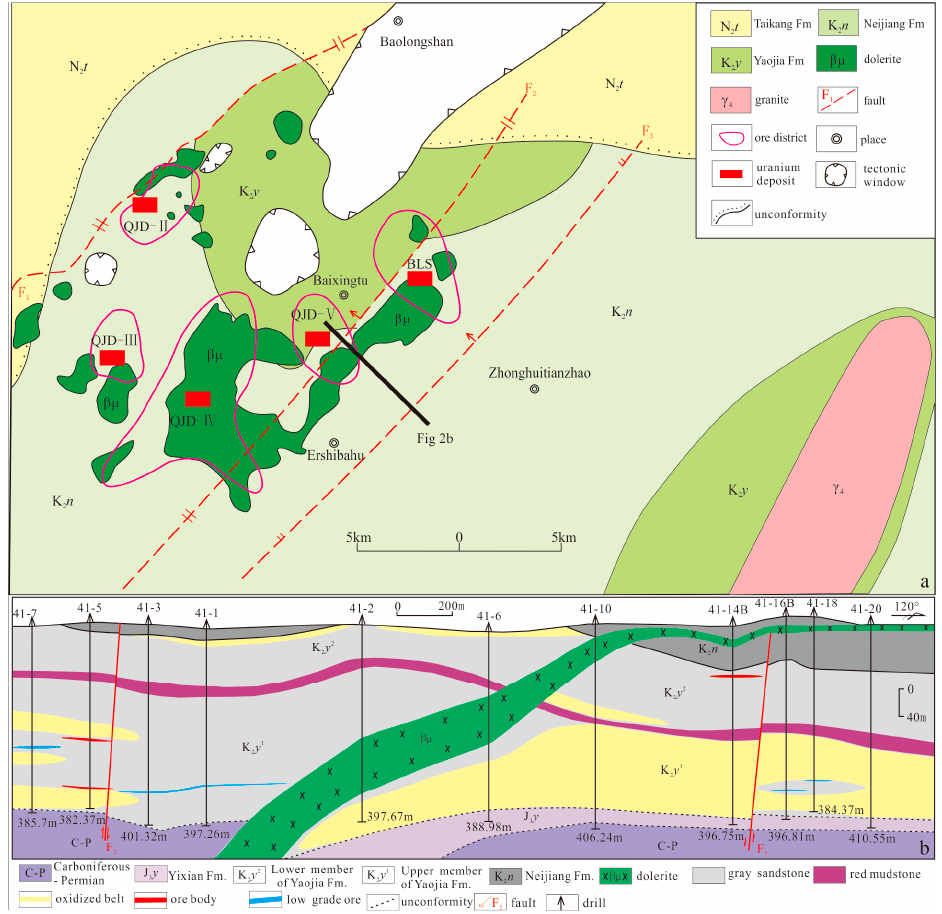
Figure 2. Plane ( a ) and profile ( b ) distribution of uranium deposits and dolerite in Qianjiadian ore field (a modified from [35]).